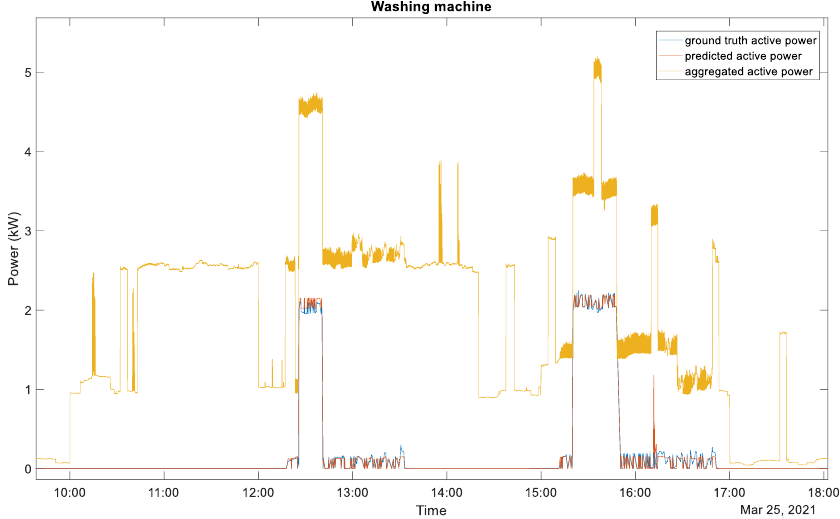
Figure 6. Disaggregation output of the washing machine. Blue, ground truth active power; red, predictive active power; yellow, aggregate active power.